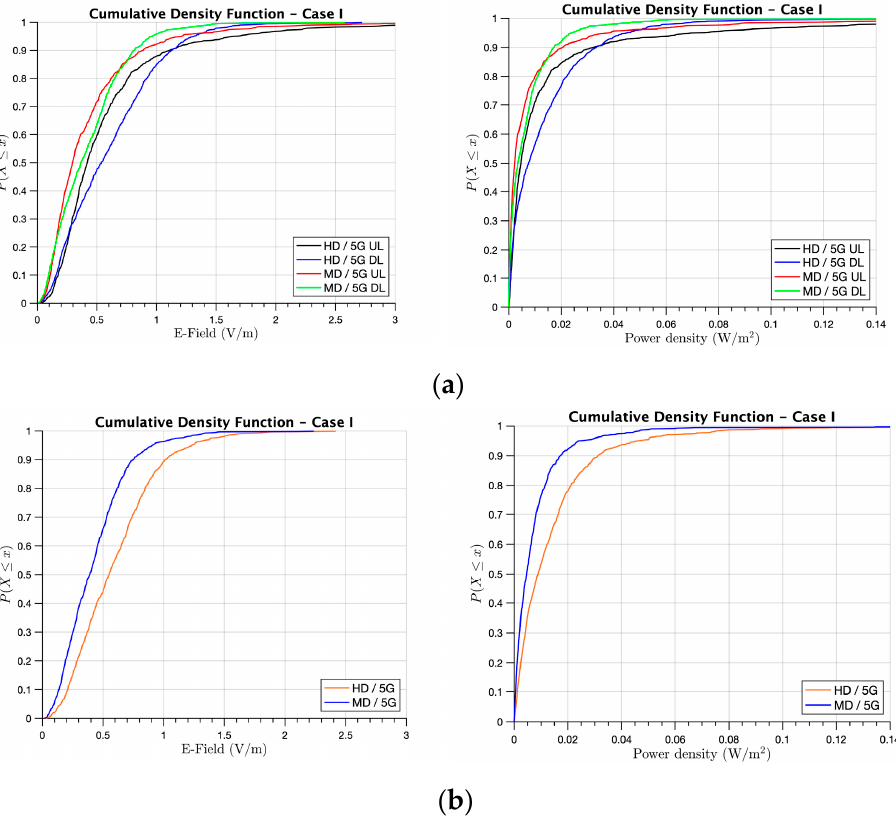
Figure 10. CDF of the received E-field and power density for Case I at the XY bi-dimensional plane at head height when the people were working on the first floor of the library: ( a ) UL and DL comparisons for HD and MD and ( b ) the total E-field exposure and power density for HD and